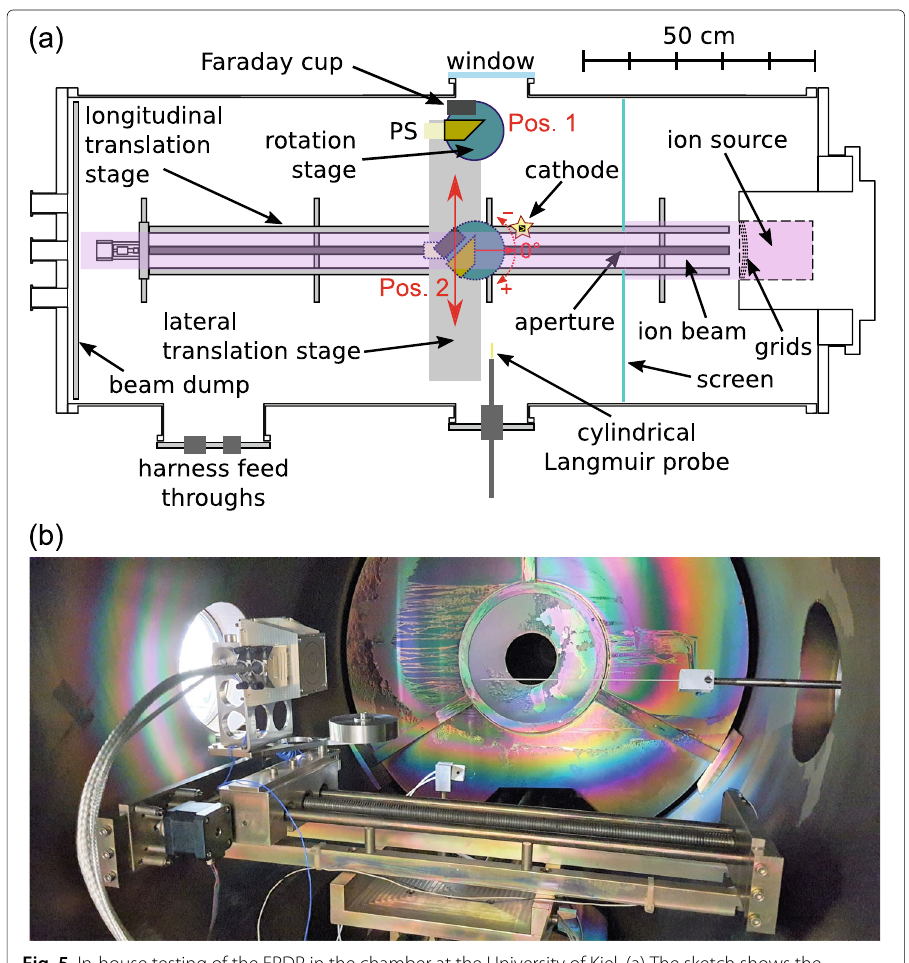
Fig. 5 In-house testing of the EPDP in the chamber at the University of Kiel. (a) The sketch shows the geometrical arrangement of the ion beam and the EPDP plasma sensor head (PS). The EPDP is mounted together with additional diagnostics on the translation and rotation stage. (b) The photograph shows a view into the chamber from the position of the removed beam dump. The rotation stage is moved to the left, just as in the sketch. (The disk-like steel object below the plasma sensor is a counter weight, which is needed for mechanical stability of the rotation stage.) At the right side of the photograph, one can see the additional movable cylindrical Langmuir probe; its tip is currently at the symmetry axis of the cylindrical chamber. Behind the stage, the aperture for the Xe beam is visible. The colorful shimmer at the aperture plate and